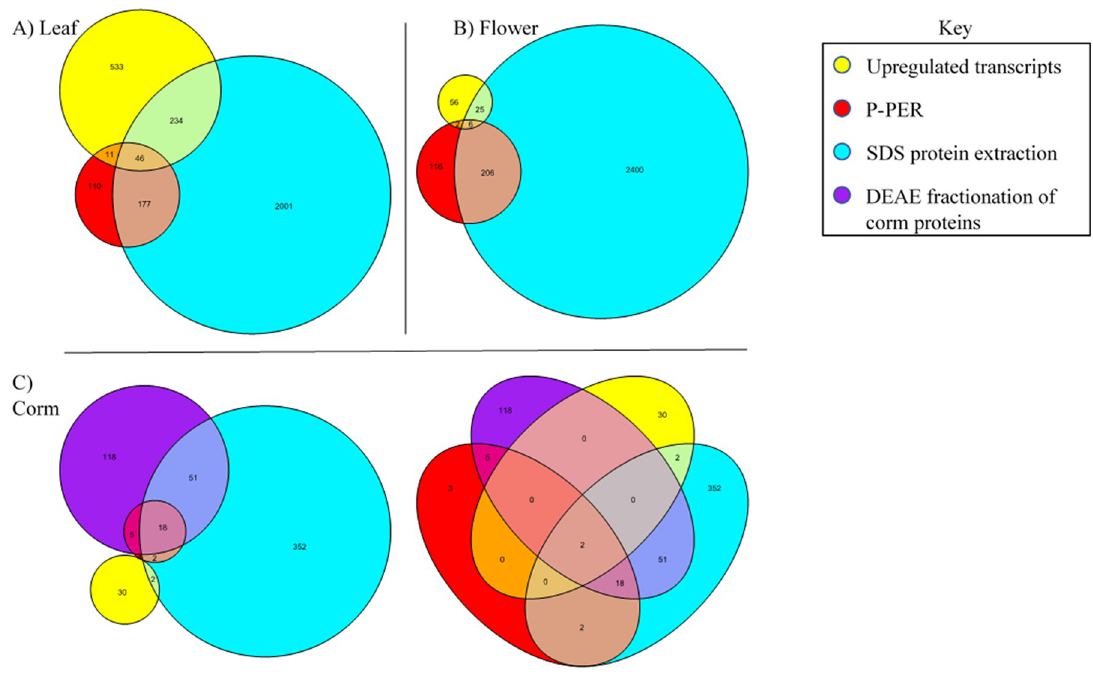
Fig 4. Proteomic confirmation of upregulated transcripts in the leaf, flower and corm tissues. The proteomic extraction methods are exhibited proportionally in Euler diagrams for A) leaf, B) Flower and C) Corm. A Venn diagram is included in C to display the 2 transcripts identified in all proteomic extracts as well as upregulated